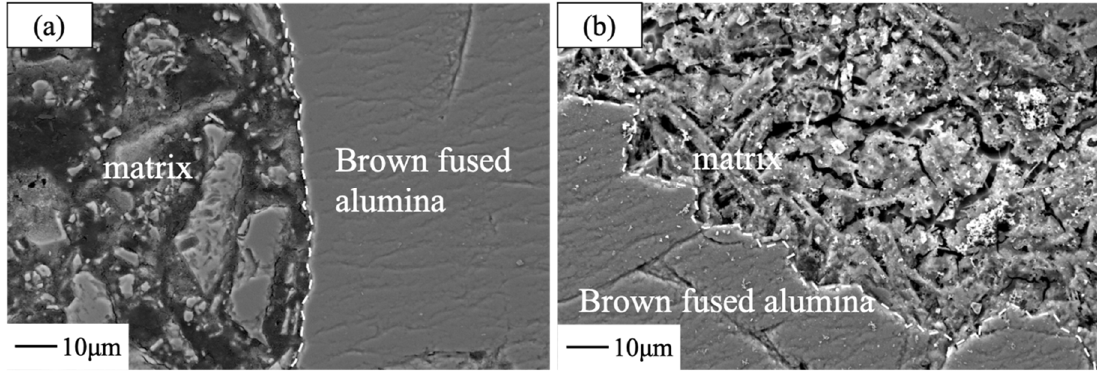
Figure 6. Backscattered images of the polished castable specimens ( a ) M and ( b ) F4 after calcining for 3 h at 1450 °C.